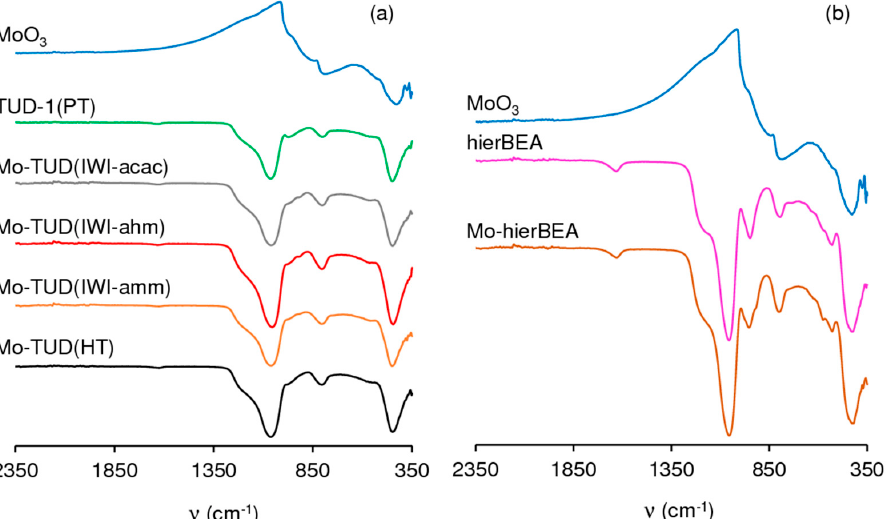
Figure 5. ATR FT-IR spectra of ( a ) TUD-1 type and ( b ) BEA type materials prepared. For comparison, the spectrum of bulk MoO 3 is included in ( a , b ).